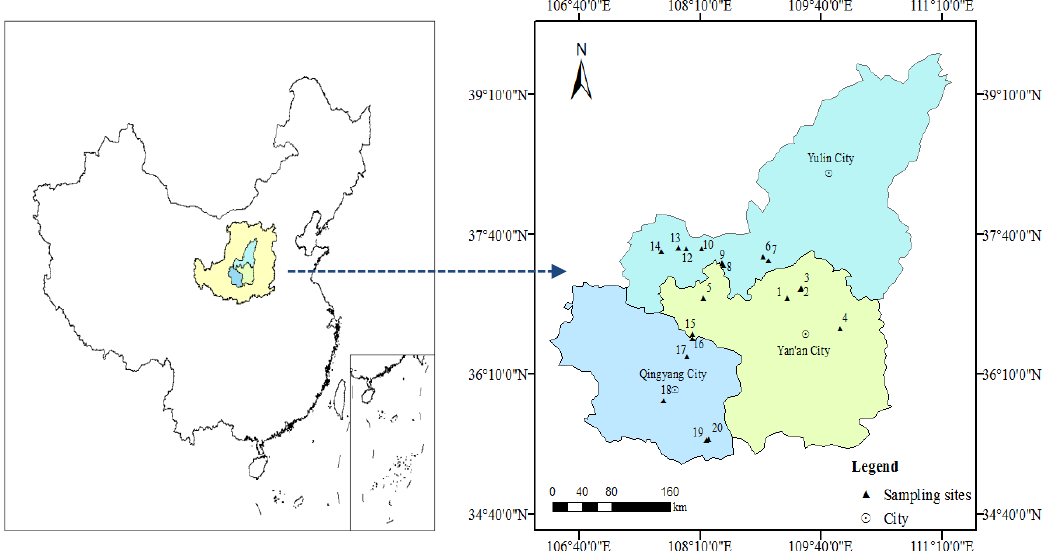
Figure 1. Map of the study area.